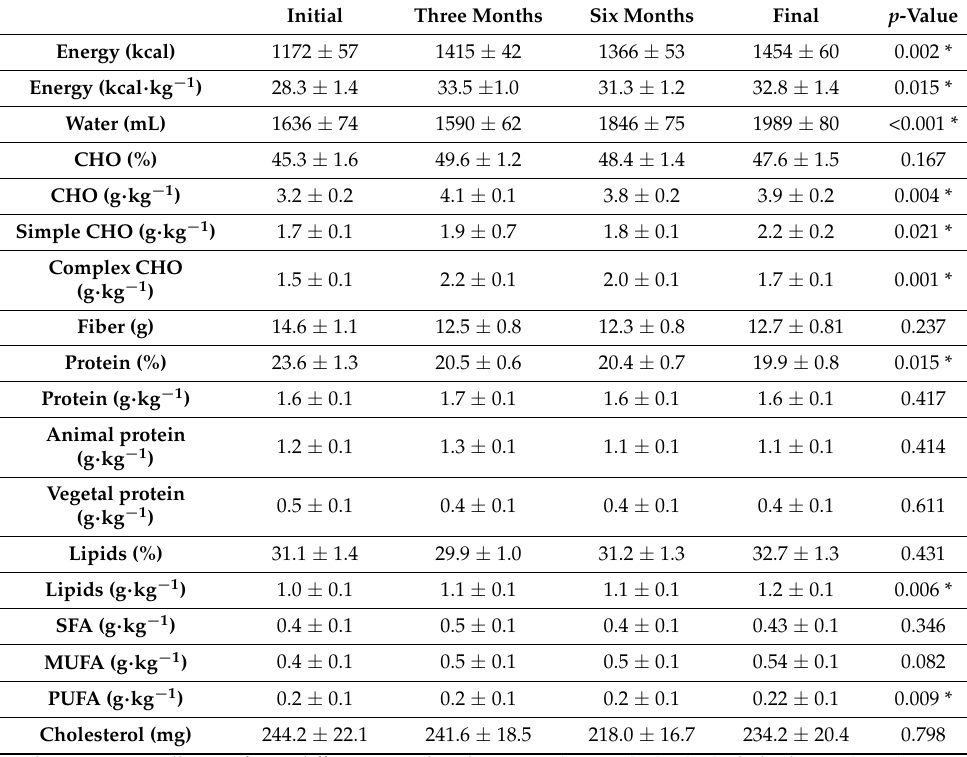
Table 1. Changes in daily energy, macronutrient, and water intakes during the